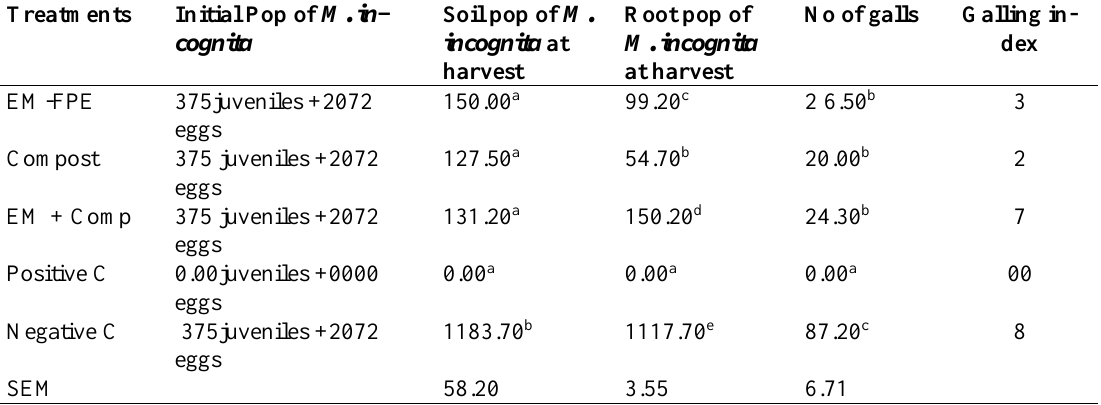
Table 8 Effect of treatment on soil and root populations of Meloidogyne incognita in the rhizosphere of tomato plants under screenhouse conditions